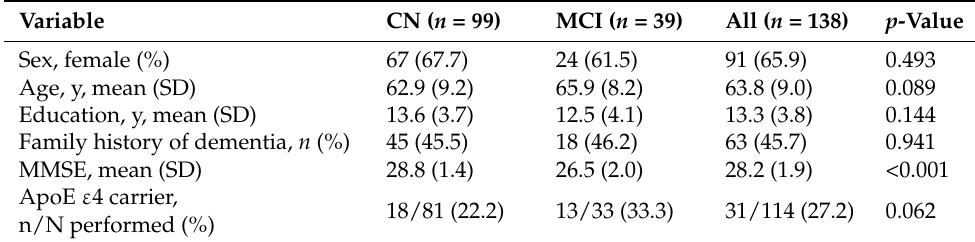
Table 1. Participants’ characteristics at baseline by clinical diagnosis.